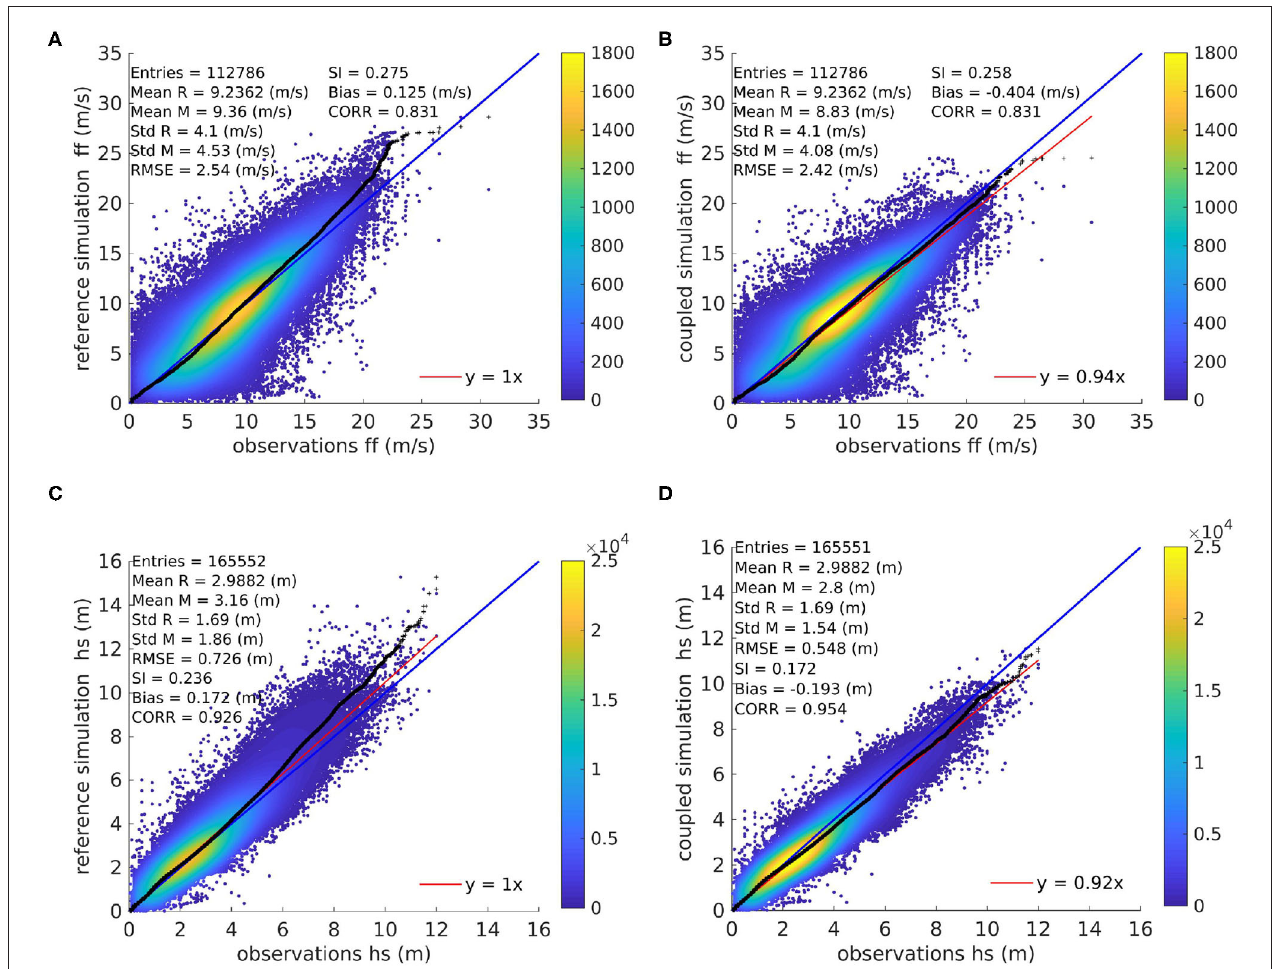
FIGURE 8 | Q-Q scatter plots for the measured (Sentinel-3A and GTS) (reference, R) and modelled (M) wind speeds (A,B) and significant wave heights (C,D) with the reference (ref.nsn) (A,C) and coupled (cpl.nsn) (B,D) ensemble model simulations. The Q-Q plot is shown as black crosses, the 45 ◦ reference line is denoted by the blue line, and the least-squares best-fit line is the red line. The equations for the statistical values are provided in the Supplementary Material